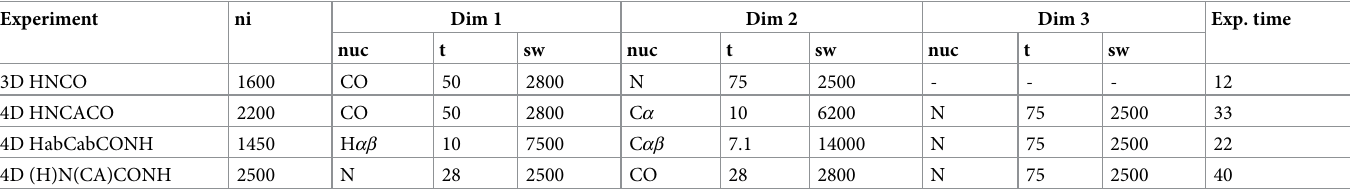
Table 1. Experimental parameters: ni (number of hypercomplex increments), nuc (name of nucleus), t (maximum evolution time in ms) and sw (spectral width in Hz). Experimental time is given in hours.